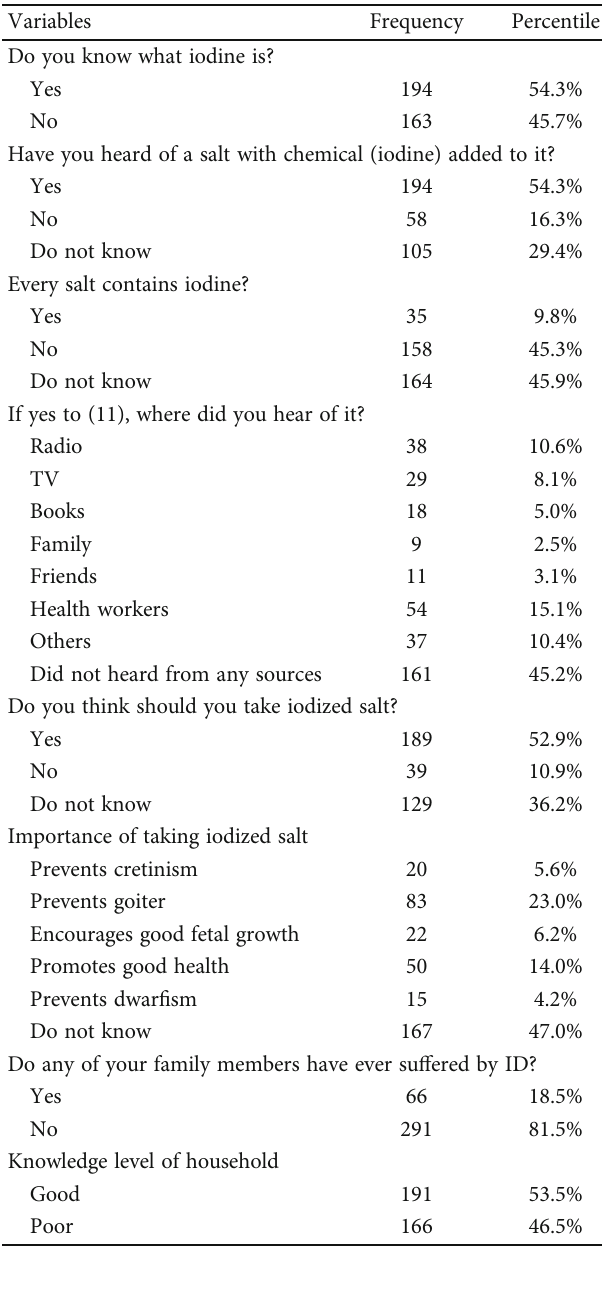
Table 2: Frequency distribution of respondents ’ knowledge about iodized salt in the study